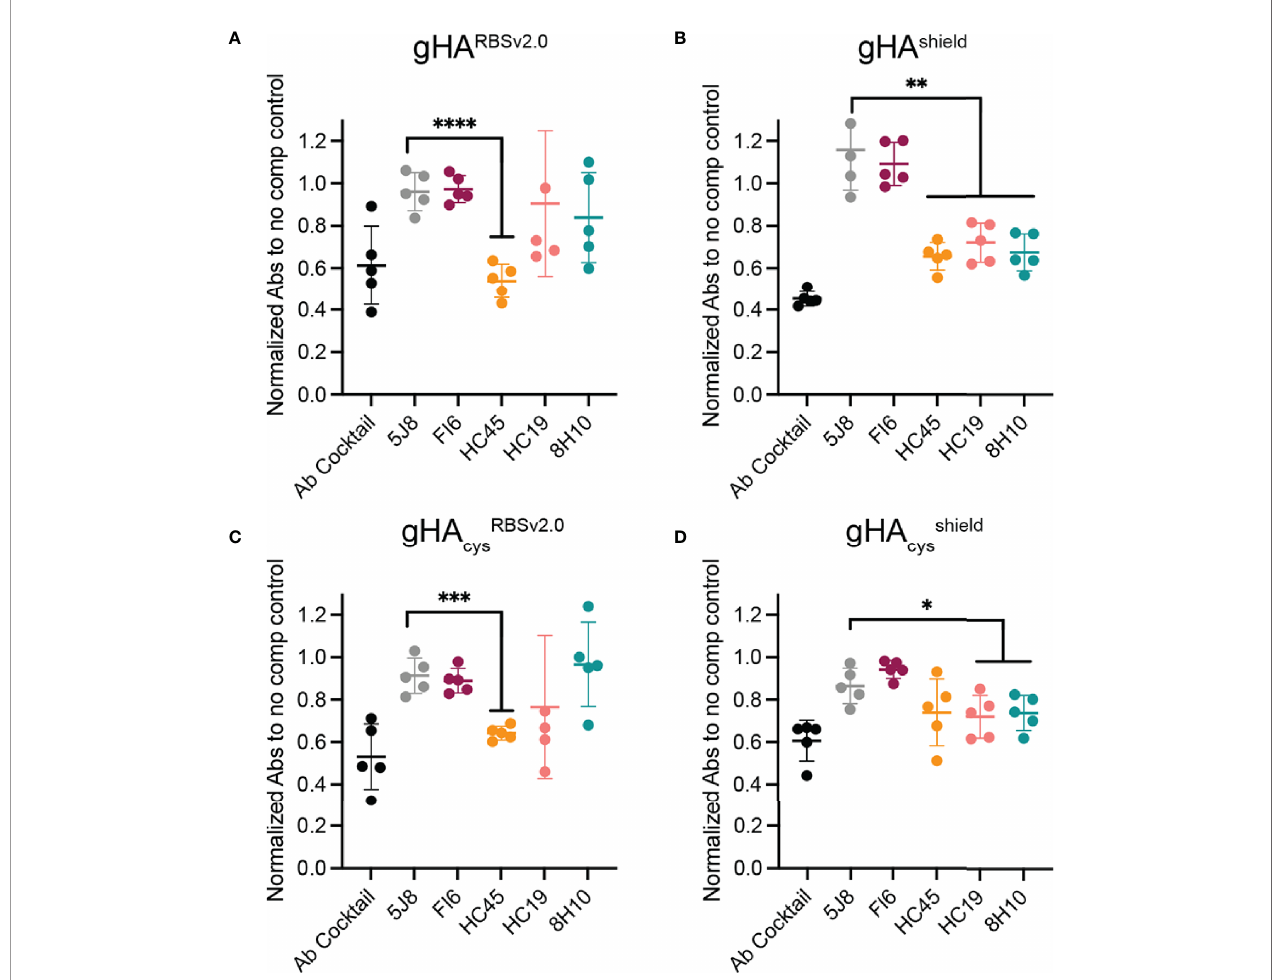
FIGURE 4 | Epitope mapping gHA elicited serum response. A serum competition ELISA with structurally characterized antibodies was used to epitope map elicited serum responses by gHA immunogens: gHA RBSv2.0 (A) , gHA shield (B) , gHA cysRBSv2.0 (C) and gHA cysshield (D) . Day 28 serum from gHA RBSv2.0 (A) , gHA shield (B) , and gHA cysRBSv2.0 (C) elicited a signi fi cant HC45-like response. None of the gHA immunogens elicited a signi fi cant FI6-like response. Statistical signi fi cance was determined by a student ’ s t-test with Welch ’ s correction relative to negative control (5J8). (*P < 0.05; **P < 0.01; ***P < 0.001; ****P <